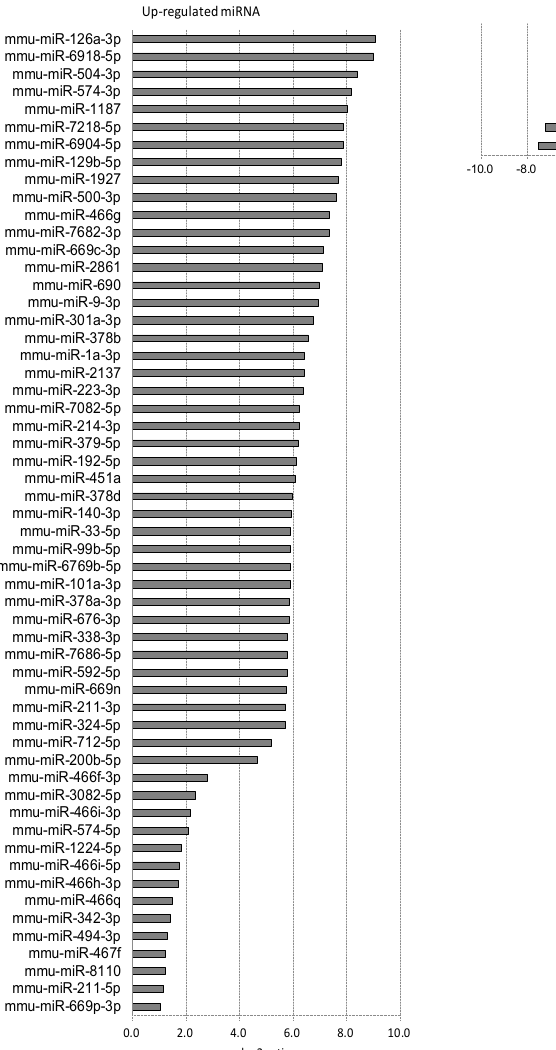
* 1 Detected flag indicated and expression ratio 2 times over or 0.5 times less both groups. * 2 Not detected flag was indicated in numerator, but detected flag in denominator and expression ratio of 5 times over. * 3 Not detected flag was indicated in denominator, but detected flag in numerator and expression ratio of 0.2 times less was showed. Int. J. Mol. Sci. 2019 , 20 , 3629